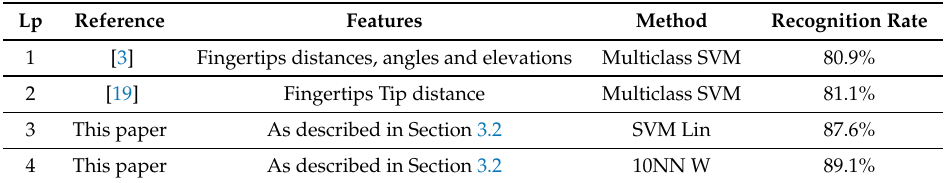
Table 13. 10-fold cross validation results of different methods obtained for the Dataset